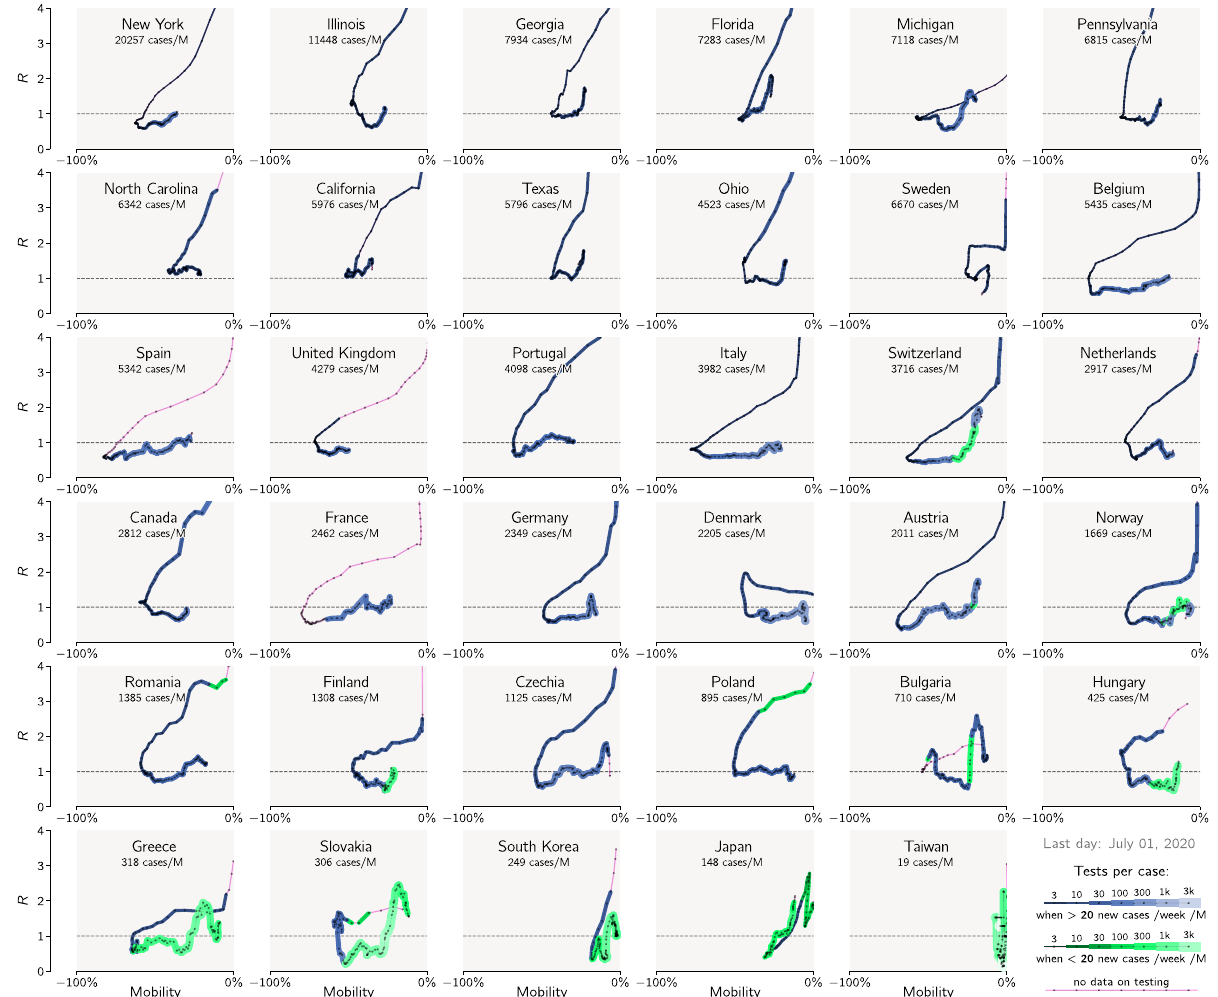
Figure 2. Epidemic trajectories of countries and states analyzed in Fig. 1 in the (mobility reduction)–(effective reproduction number) plane. The value of the effective reproduction number, R , has been estimated based on the reported number of daily new cases. The trajectories begin in February and end on July 1, 2020, and have a single-day resolution. Line thickness increases with the reported number of tests per case (positive of fronts and make them more robust with respect to small (and random) differences in values of considered objectives. The first optimal front ( first layer) consists of a single country, Taiwan, which has simultaneously the smallest cumulative lockdown and smallest population-normalized number of deaths; both next two optimal fronts also contain a solitary East Asian country, South Korea and Japan; the fourth optimal front contains four European countries: Slovakia, Norway, Greece, and Denmark. The first pessimal front ( last layer) contains New York State (with the highest population-normalized number of deaths), Spain, and UK (with the highest cumulative lock- down); the second pessimal front is spanned by the state of California, and France, Italy and Belgium; the third, broad pessimal front groups several US states, Canada, and Portugal. High correlation between cumulative lockdown and population-normalized cumulative number of deaths can be explained by analysis of trajectories of individual countries in the (mobility reduction)–(effective reproduc- tion number) plane, see Fig. 2. The effective reproduction number R (equal β/γ in the SEIR model that we used to estimate R 5,6 ) is calculated from the number of daily new registered cases as explained in “Methods”. In the countries that are close to the current Pareto-pessimal front (last layer), the epidemic had three distinguishable phases, depicted schematically in Fig. 3. In the initial phase, characterized by a high R value and no mobility reduction, R decreases due to suppression of potential super-spreading events and social distancing. In the next phase, R drops below 1 due to the reduction of mobility, which leads to a decrease of the contact rate β . When analyzing individual trajectories plotted in Fig. 2 we may notice that in the second phase the number of tests per case (indicated by line width and color intensity) remains constant or decreases (possibly due to saturation of the capacity of facilities that perform tests), suggesting that in this phase the removal rate γ remains constant or decreases. This confirms that the reduction of mobility, and thus β , was instrumental in bringing R below 1.